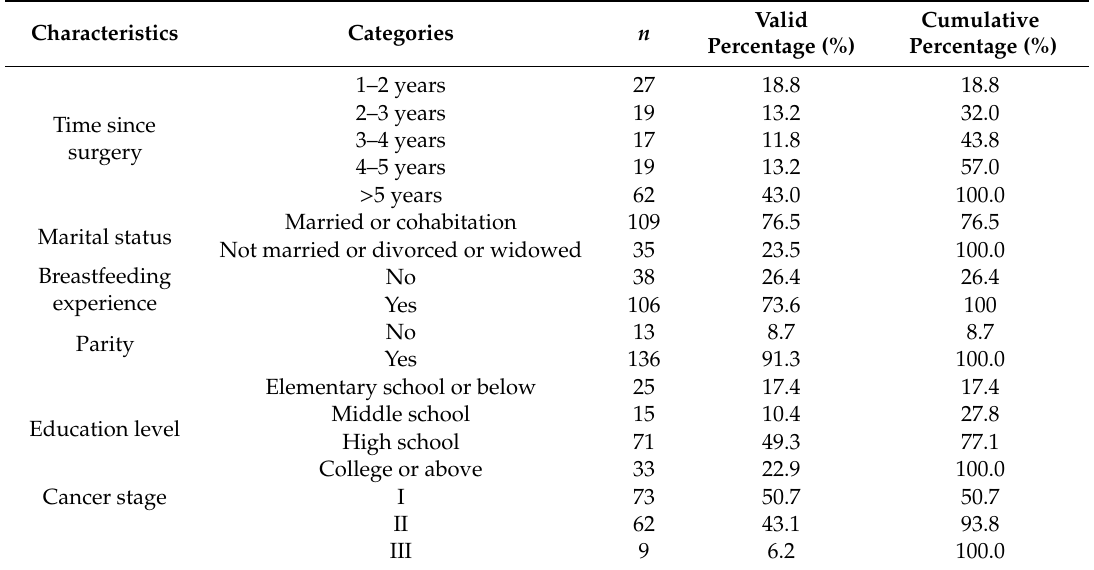
Table 1. General characteristics of participants ( n =